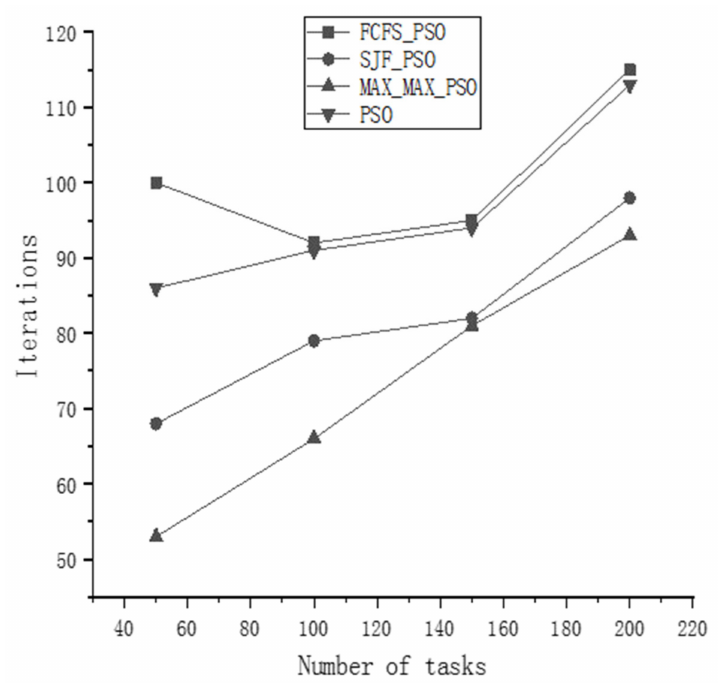
Figure 4. Convergence of different